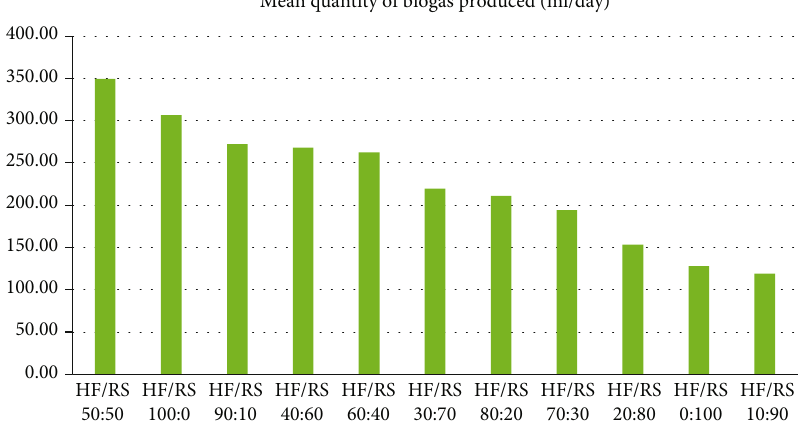
Figure 2: Decreasing order of gas production. Table 3: Di ff erence in the potential of biogas yield from di ff erent combinations of HF and RS. Di ff erent combination Mean di ff erence